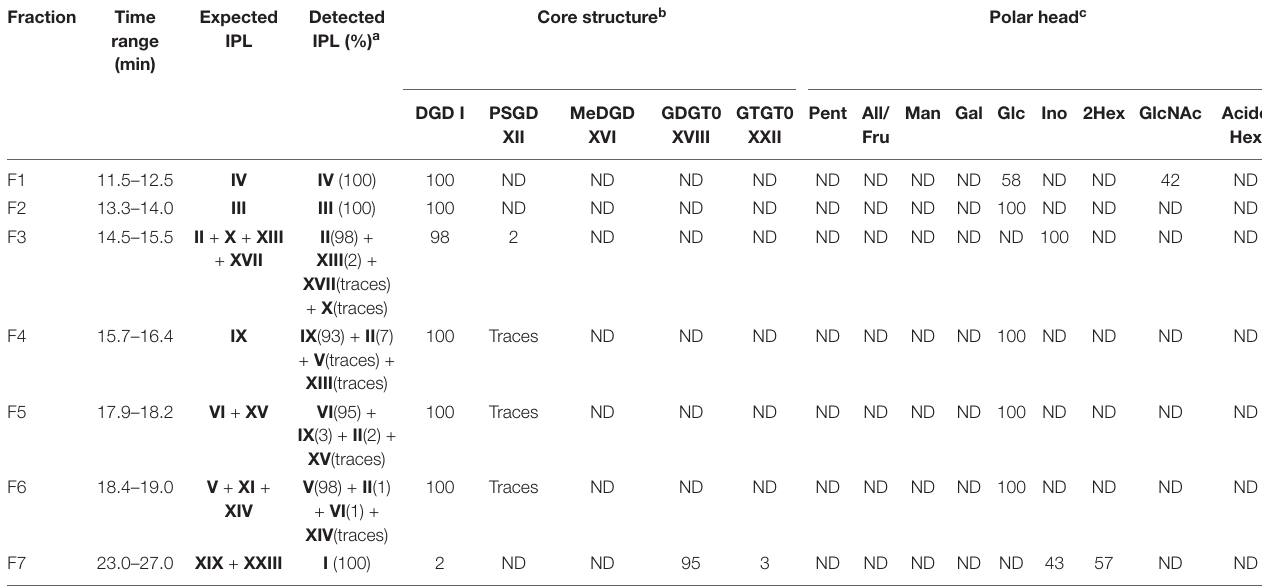
TABLE 2 | Characteristics and distribution of the core structures and the polar head groups of purified major lipids of Thermococcus barophilus . Fraction